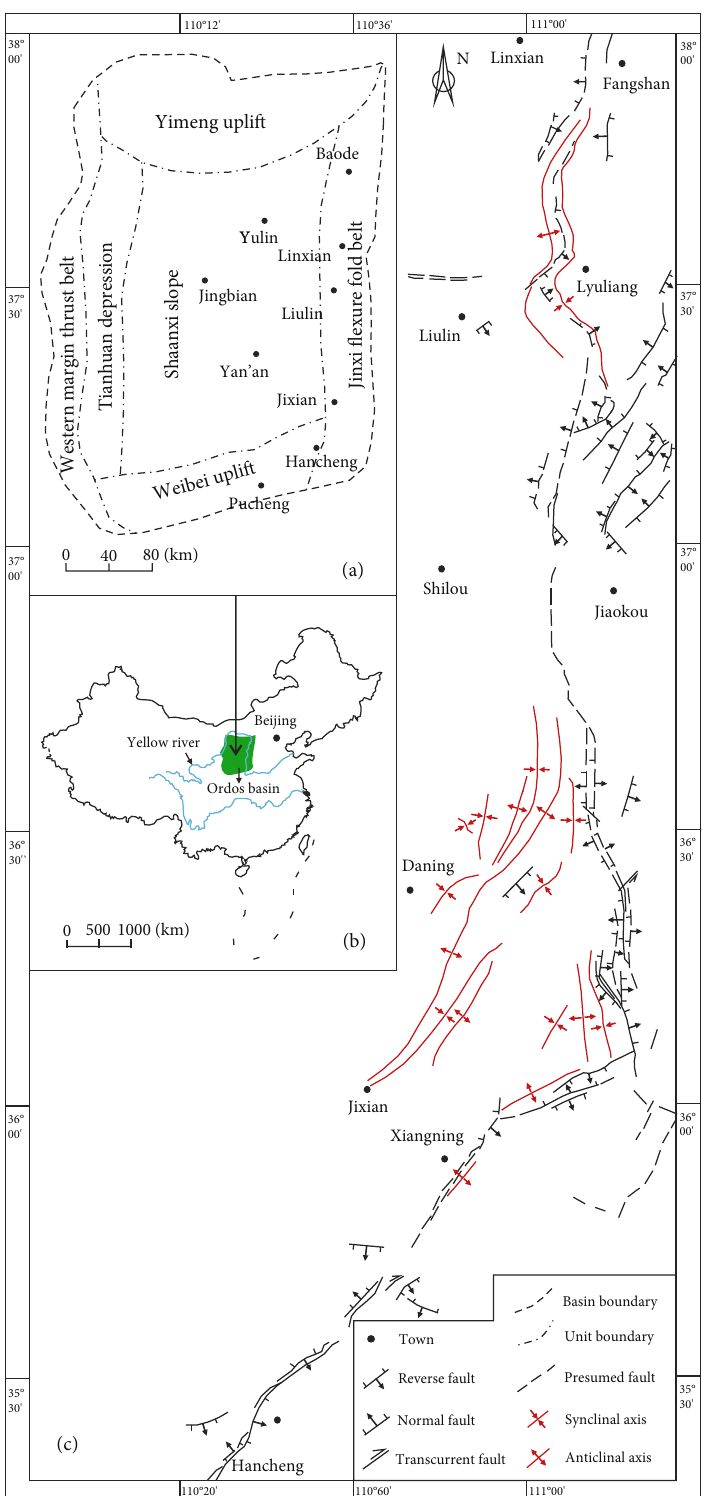
Figure 1: Location and major geological structures in the EMOB. (a) Structural units of Ordos Basin. (b) Location of Ordos Basin. (c) Major geological